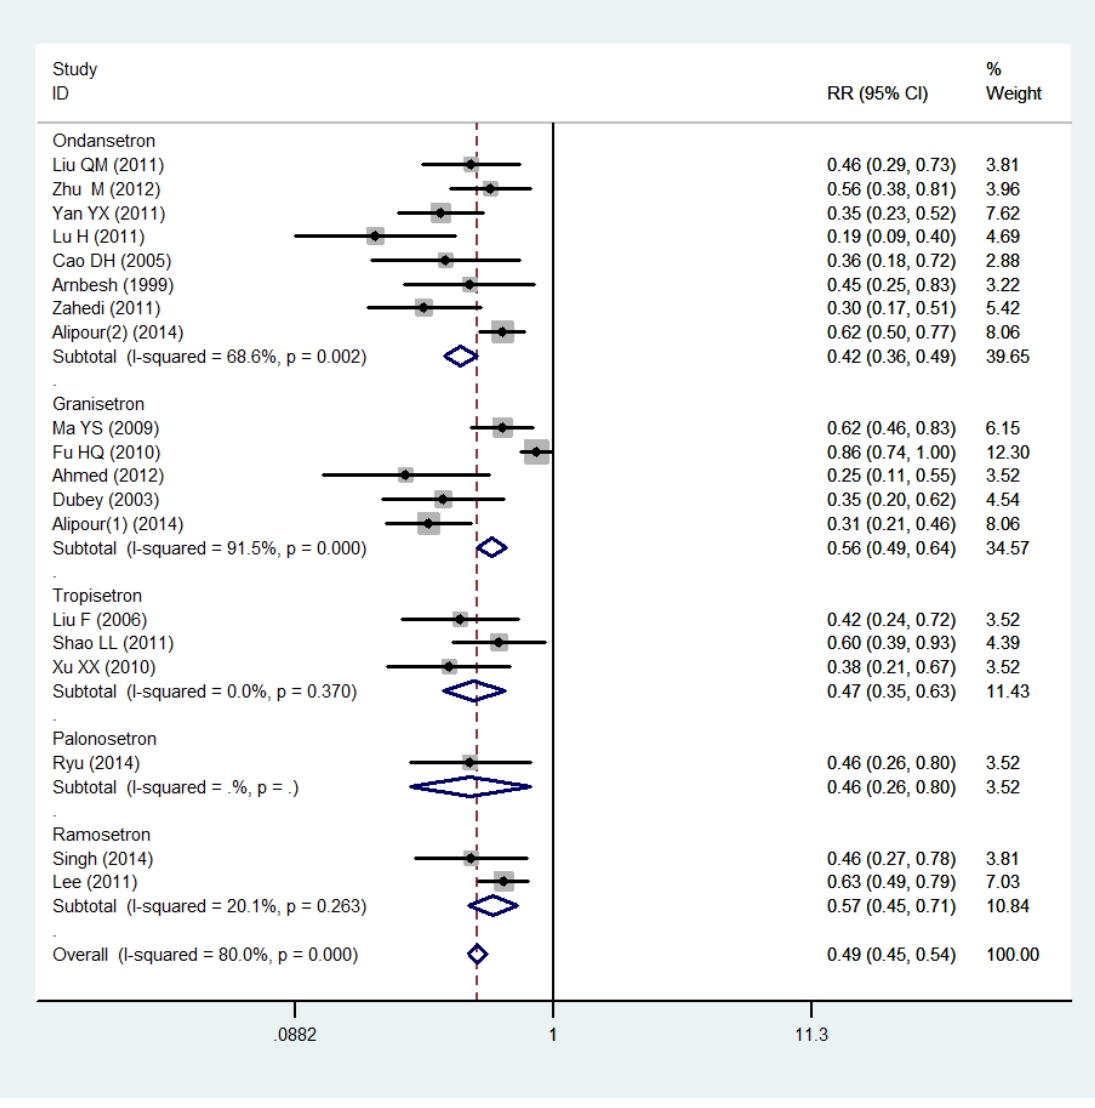
Figure 2 : A forest plot of the propofol injection pain incidence between 5-hydroxytryptamine 3 receptor antagonists and control groups. (RR, risk